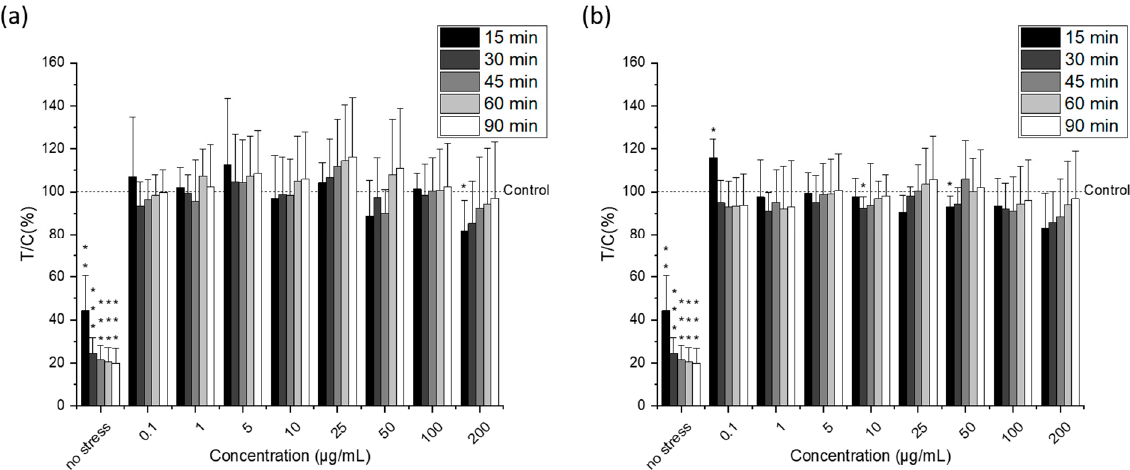
Figure 7. H 2 O 2 -induced ROS-levels in HCT-116 cells after incubation for 24 h with different concen- trations of the omega-3 lipid extracts produced by the traditional method ( a ) and the green method by using Saczyme ( b ) measured by the protective dichlorofluorescein (pDCF) assay. Cells were stressed for 90 min with 1 mM H 2 O 2 whereas fluorescence intensity was measured at different times (15, 30, 45, 60, and 90 min). Results are presented as mean + SD normalized to DMSO solvent control (0.5%; T/C in %) (n = 6). Statistical differences compared to the DMSO solvent control were calculated with a one-sample Student’s t -test (* p , ** p , *** p < 0.05, 0.01, 0.001).